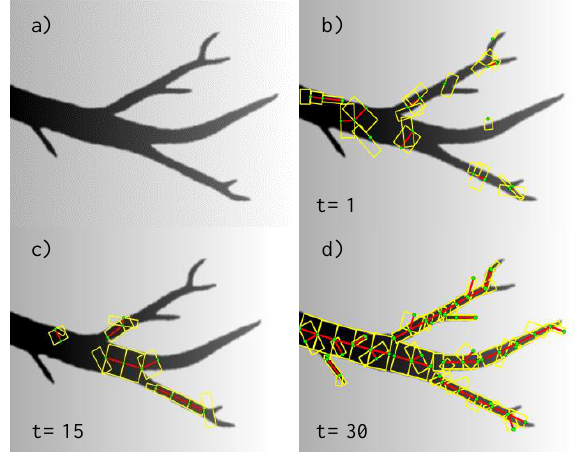
Figure 5. As the number of iterations t [in millions] increases, the tidal channel network is better and better described by the graph (green: junction points, yellow: their outgoing segments, red: edges in the graph).